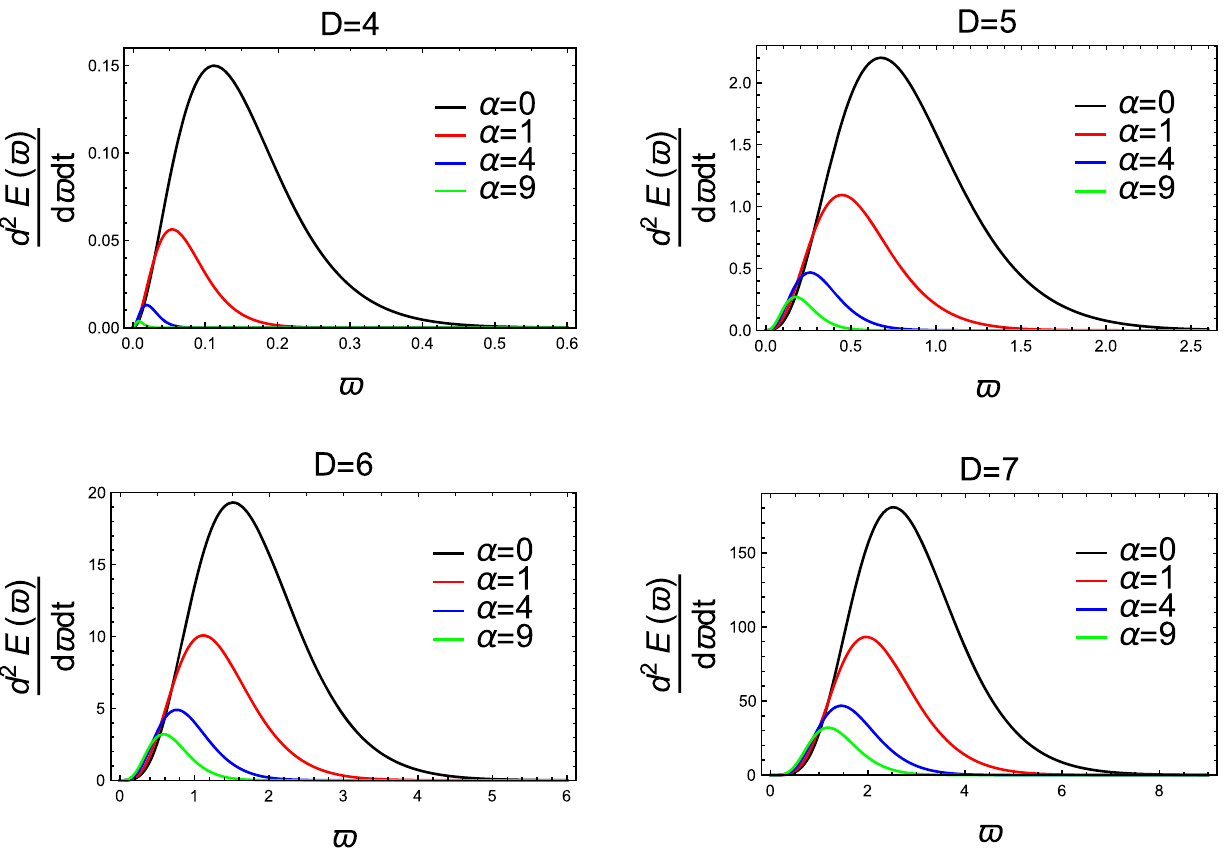
Fig. 6 The energy emission rate d 2 E ((cid:16)) with respect to the emission frequency (cid:16) for different values of α , where the spacetime dimension is d (cid:16) d t taken to be D = 5 , 6 , 7, respectively, and the case of D = 4 is attached for comparison. Here we set M = 1